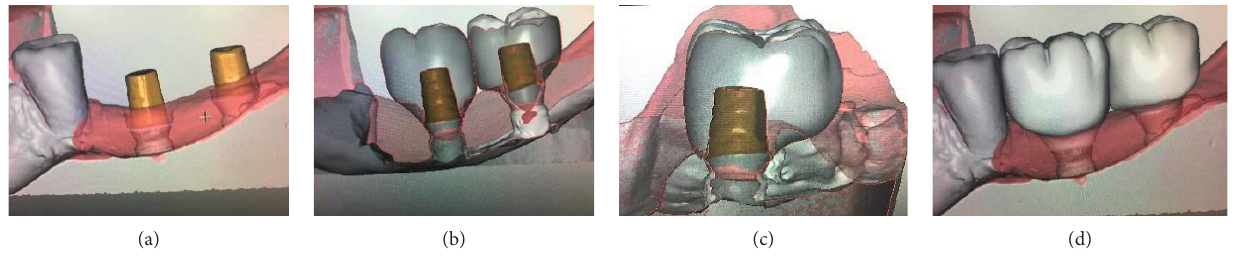
Figure 13: Stages of modeling temporary crowns on implants in the program.